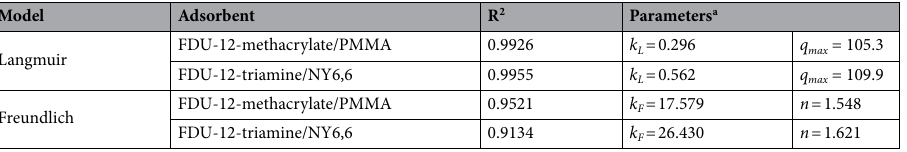
Table 2. Parameters obtained by isotherm models for the adsorption of Pb(II) onto the prepared adsorbents. a The units are as same as mentioned in the section “The effect of Pb(II) initial concentration and adsorption isotherm”.